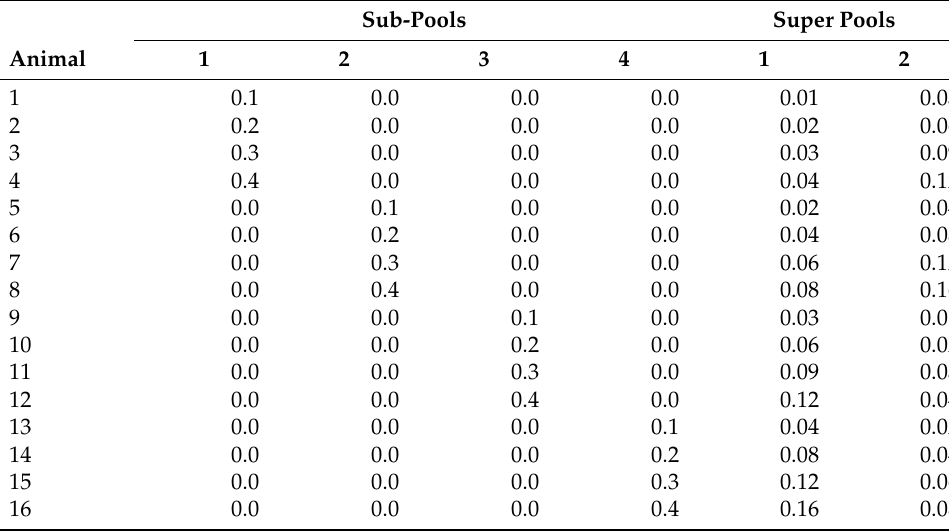
Table A2. Animal contributions to super pools and